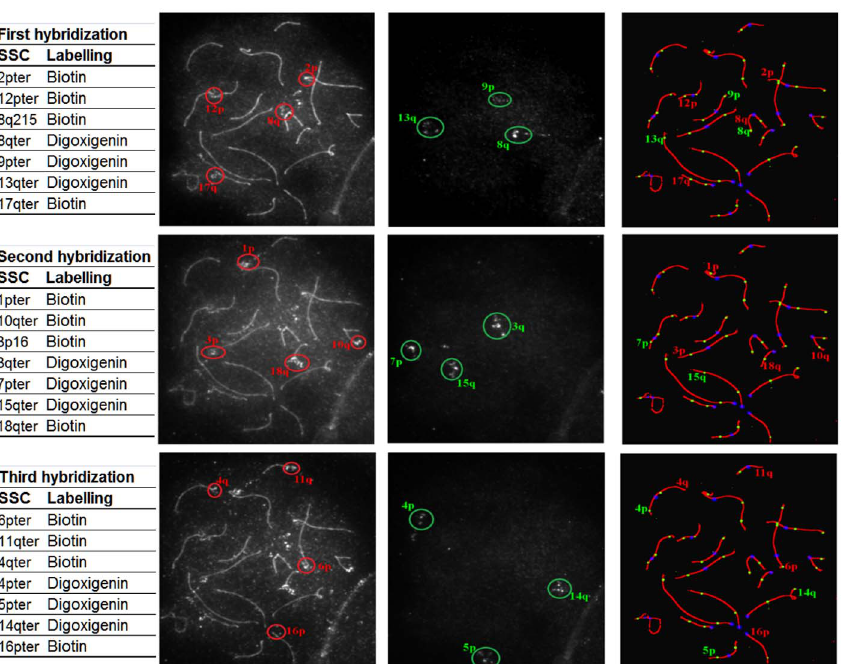
Figure 1. Example of identification of the 18 pig autosomes. 1st column: set of 7 BACs used for each hybridization with their positions and labeling nucleotide. 2nd column: raw image of the capture of the 4 BACs labeled with biotin and revealed in red. 3rd column: raw image of the capture of the 3 BACs labeled with digoxigenin and revealed in green. 4th column: identification of chromosome arms on spermatocyte after immunolocalization of SCP3 (red), MLH1 (green) and kinetochores (blue).